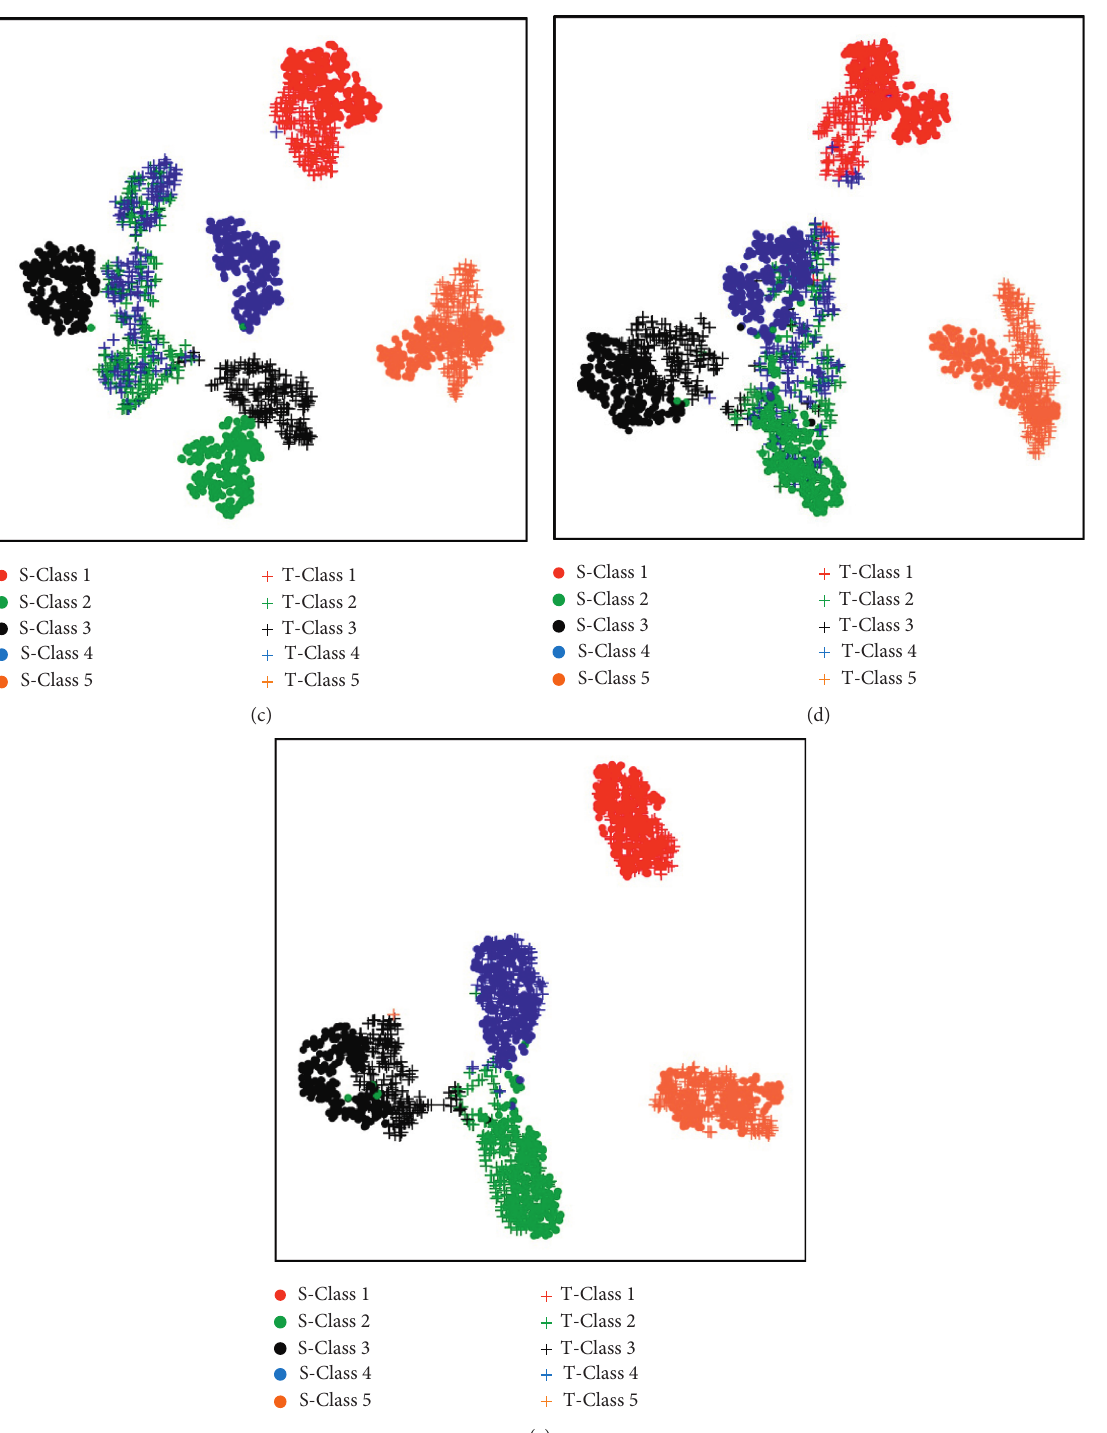
Figure 8: The t-SNE visualization of bearing test rig task T1 ⟶ T2. Five colors represent five health conditions, and the five network models are (a) CNN, (b) TCA, (c) DDC, (d) DCDAN-WDC, and (e)